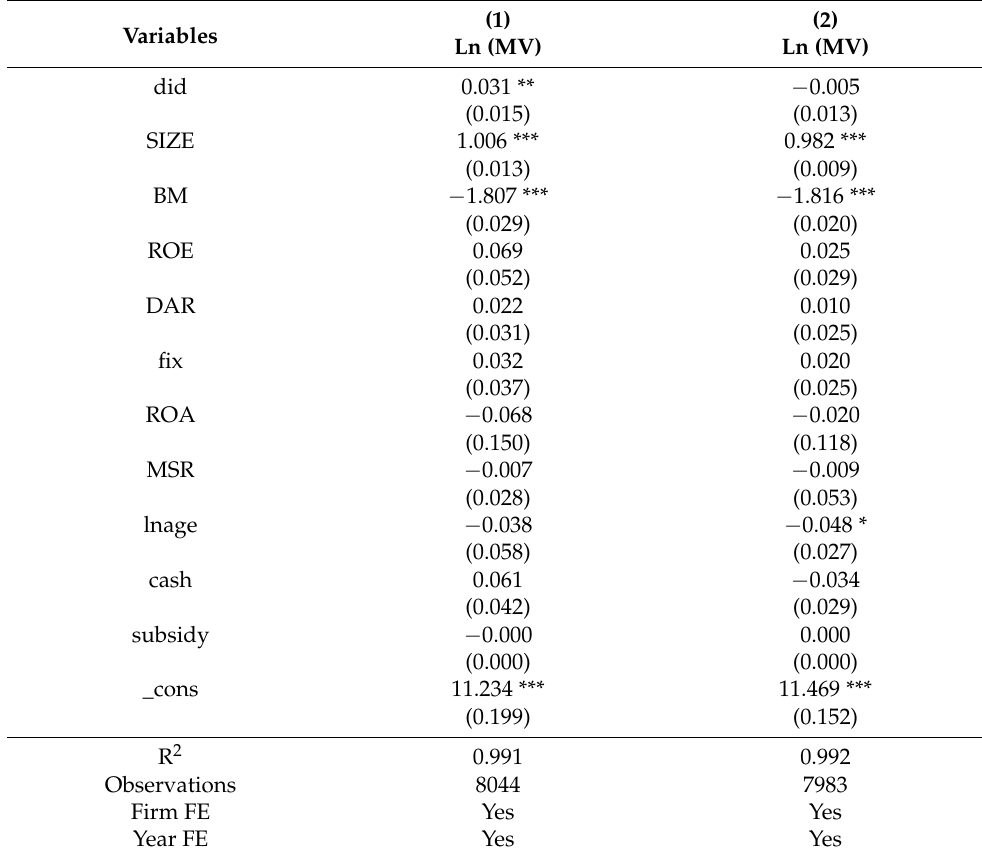
Table 12. Heterogeneous analysis of marketization